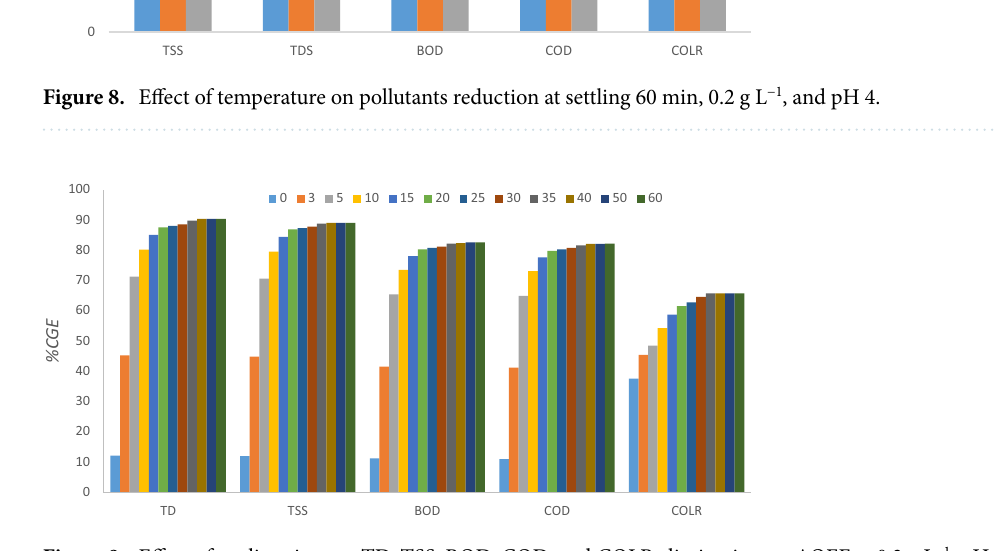
Figure 9. Effect of settling time on TD, TSS, BOD, COD, and COLR elimination on AQEF at 0.2 g L −1 , pH 4, and 303